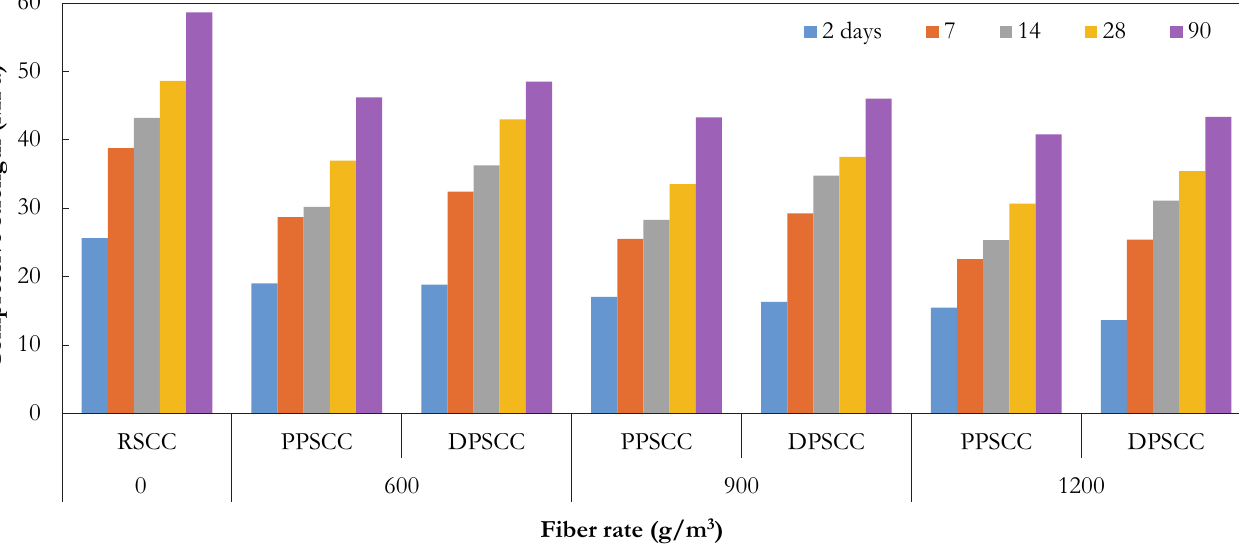
Figure 17: Effect of polypropylene and Date Palm fibers on compressive strength.